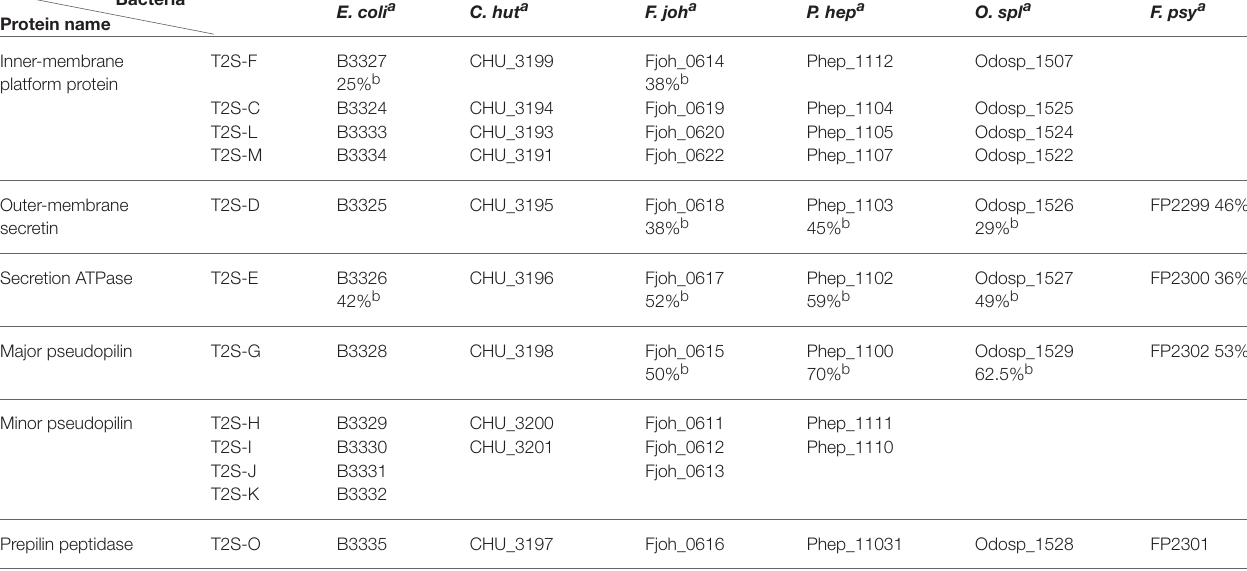
TABLE 2 | Distribution of T2SS components in E. coli, C. hutchinsonii , and four other Bacteroidetes members. Protein name